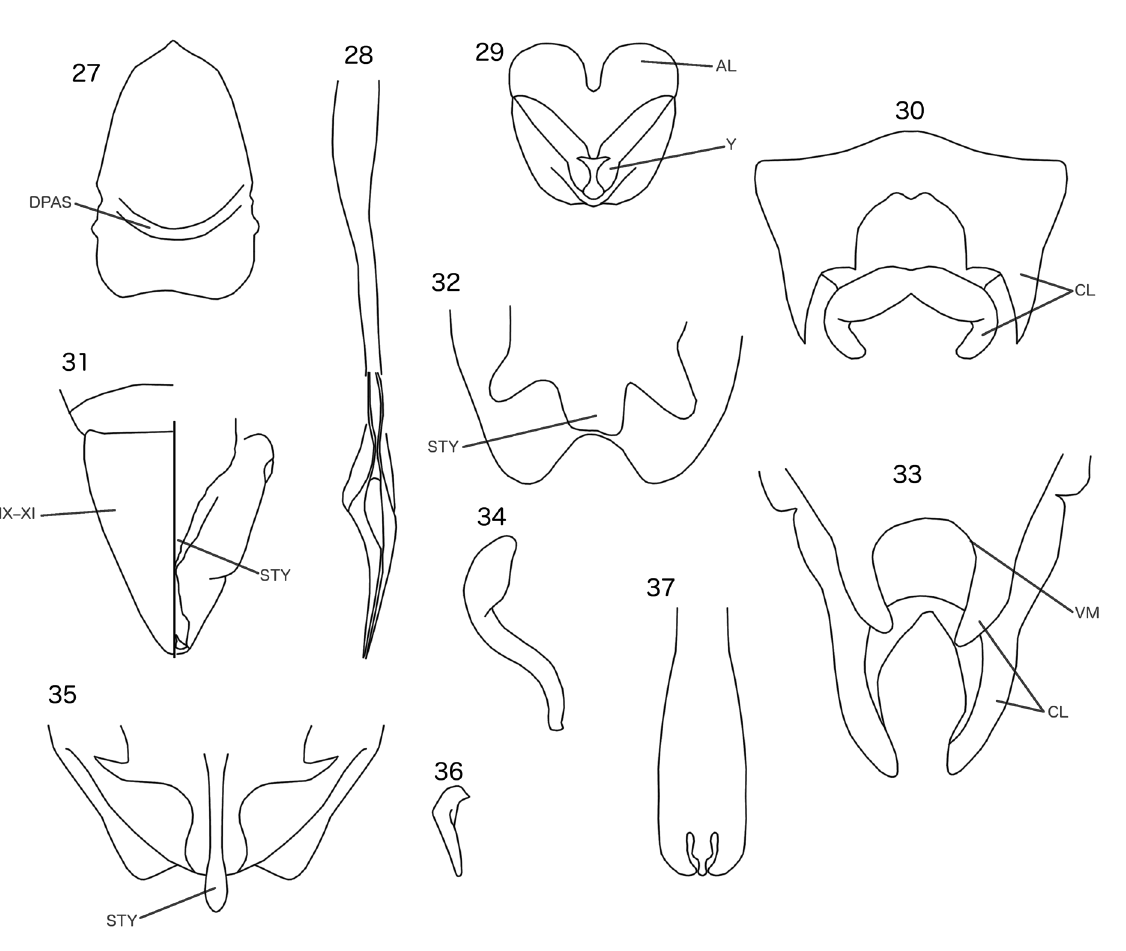
Figs 27–37. 27 . Outline of head and dorsal post-antennal suture of Oxylipeurus inaequalis (Piaget, 1880), redrawn from Mey (1990); original drawing asymmetrical. 28 . Male genitalia of Oxylipeurus inaequalis (Piaget, 1880), redrawn from Mey (1990); some details left out for clarity. 29 . Ventral view of mesosome of Megalipeurus sinensis Gustafsson et al ., 2020, redrawn from original description. 30 . Dorsal view of male terminalia of Eiconolipeurus melanotis Carriker, 1945, redrawn from original description; setae not illustrated. 31 . Dorsal and ventral views of male terminalia of Afrilipeurus vincentei Kéler, 1953, redrawn from Mey (2010); seta not illustrated. 32 . Ventral view of male terminalia and stylus of Talegallipeurus tenuis Mey, 1982, redrawn from original description; setae not illustrated; original illustration asymmetrical (Mey 1982). 33 . Ventral view of female terminalia and vulval margin of Talegallipeurus tenuis Mey, 1982, redrawn from original description; setae not illustrated. 34 . Outline of male paramere of Sinolipeurus tetraophasis (Clay, 1938), redrawn and simplified from Gustafsson et al. (2020). 35 . Outline of male terminalia and stylus of Sinolipeurus tetraophasis (Clay, 1938), redrawn and simplified from Gustafsson et al. (2020). 36 . Outline of male paramere of Reticulipeurus ithaginis (Clay, 1938), redrawn and simplified from Gustafsson et al. (2020). 37 . Distal section of male genitalia of Epicolinus clavatus (McGregor, 1917), redrawn from Carriker (1945). Abbreviations used: AL = anterior lobes; CL = “claspers”; DPAS = dorsal post-antennal suture; IX–XI = tergopleurites IX–XI; STY = stylus; VM = vulval margin; Y = Y-shaped thickening. Antennae not included in any illustration. Illustrations are not to